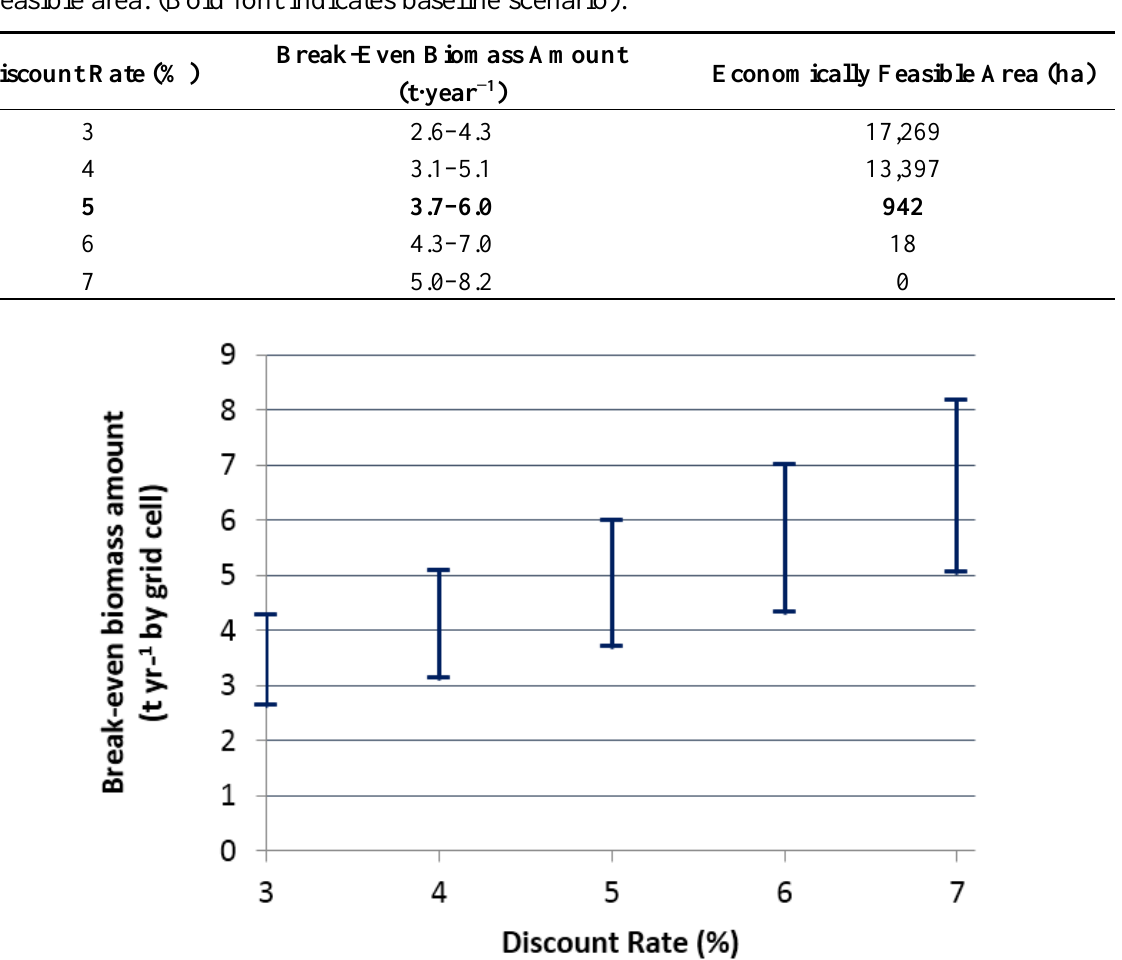
Table 1. Scenario I results: discount rate sensitivity analysis and associated economically feasible area. (Bold font indicates baseline scenario).